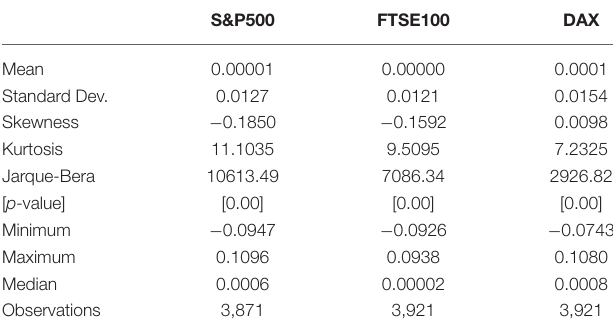
TABLE 1 | Summary statistics of the S&P500, FTSE100, DAX equity indices (ln- returns).